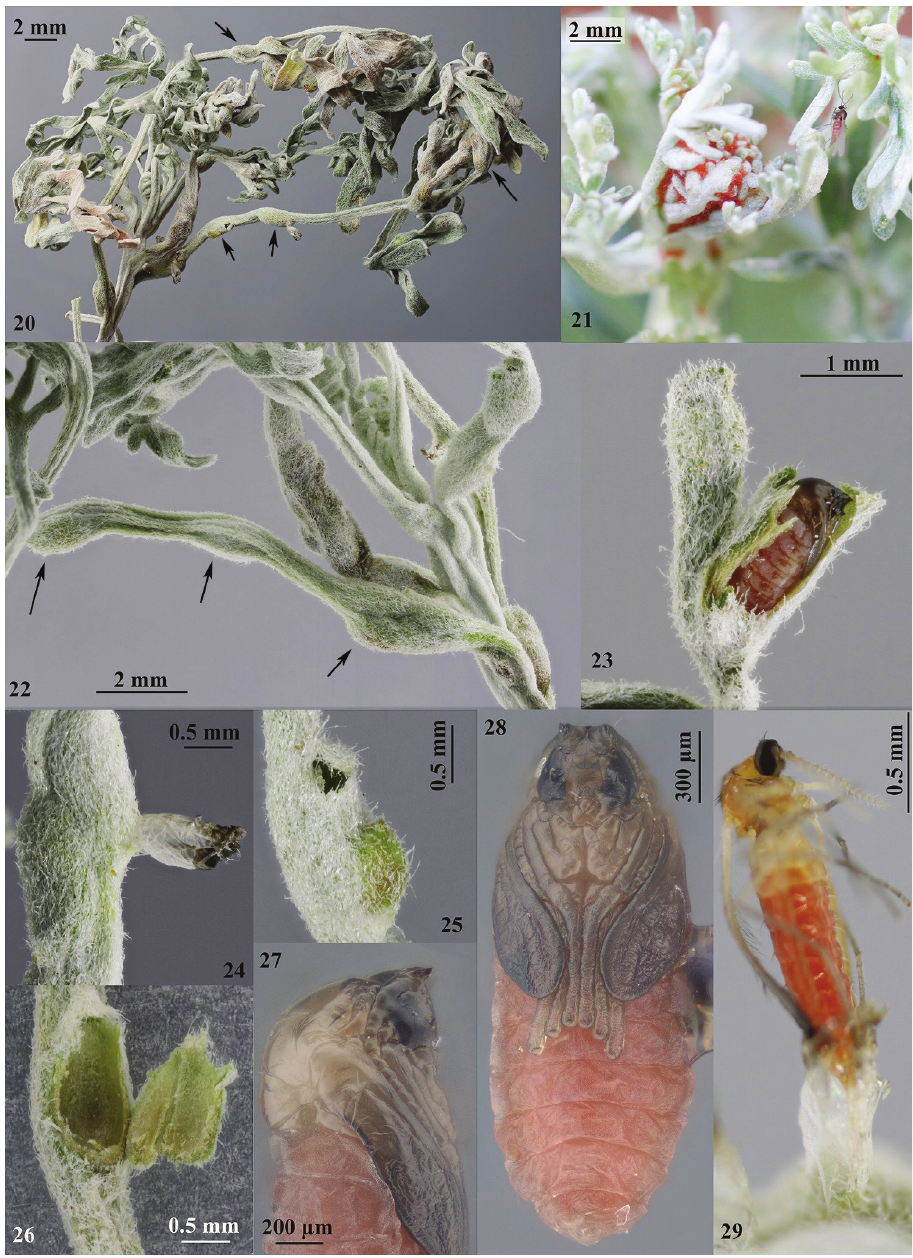
to apical leaves of the host plant covered with reddish mass of eggs 22 galls, detail 23 dissected gall show- ing a pupa 24 exuviae protruding from a gall 25 adult emergence hole 26 detail of a leaf gall showing the chamber and thin wall 27 pupa, lateral view 28 pupa frontal view 29 female emerging from